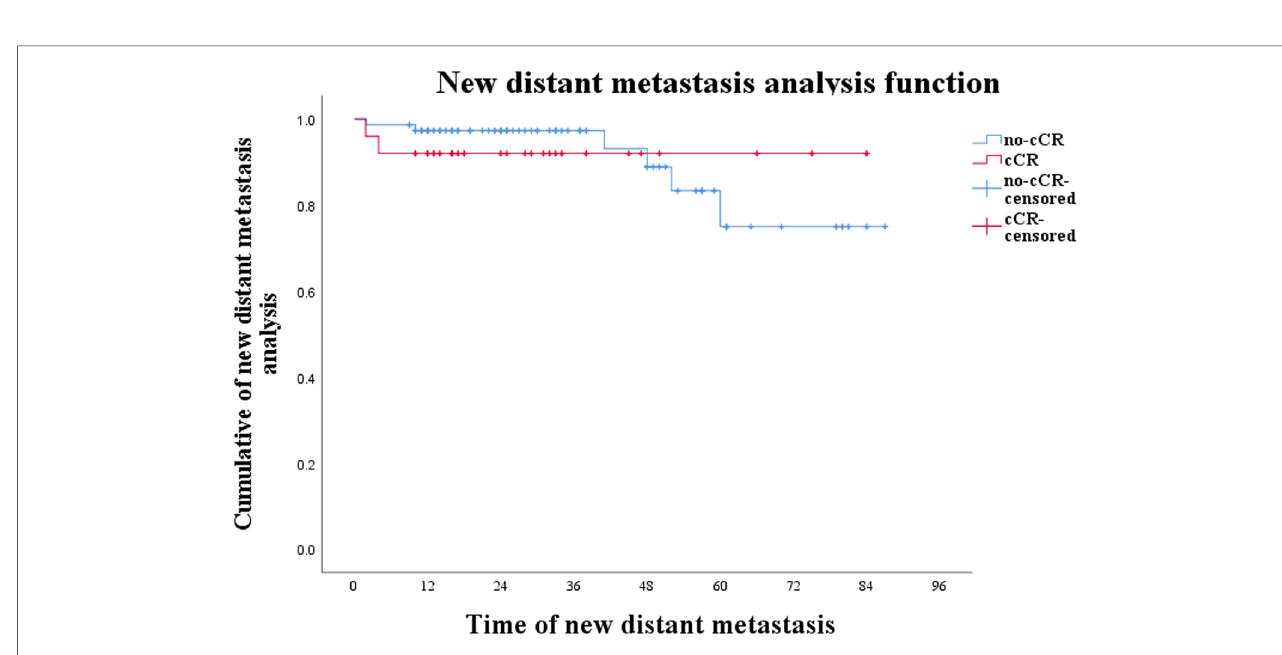
FIGURE 2 Curve of new distant metastases in CR and non-CR patients ( P